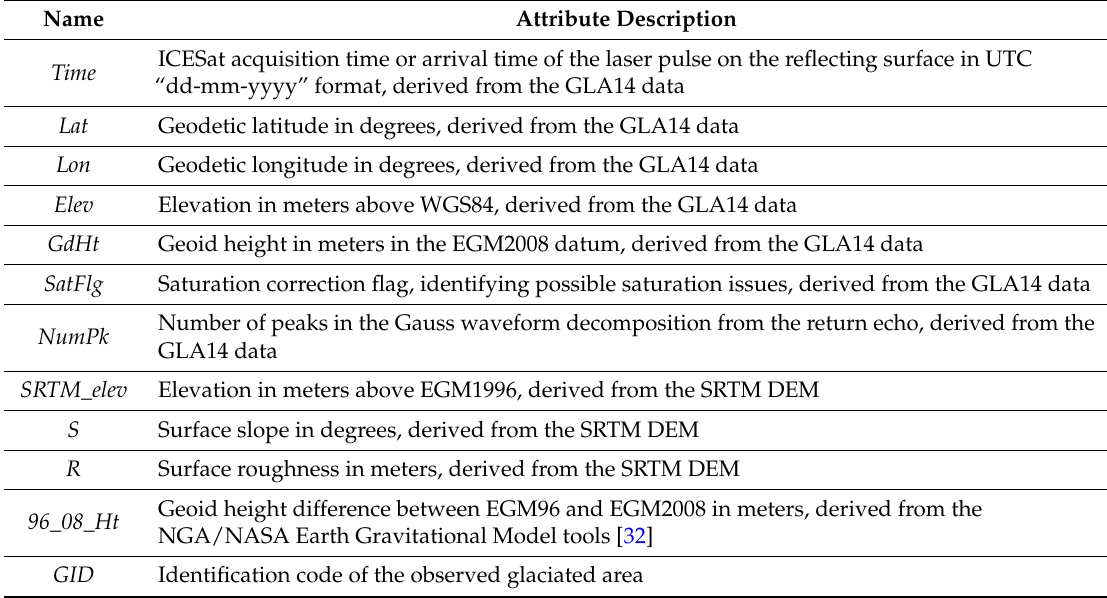
Table 1. The attributes related to each ICESat